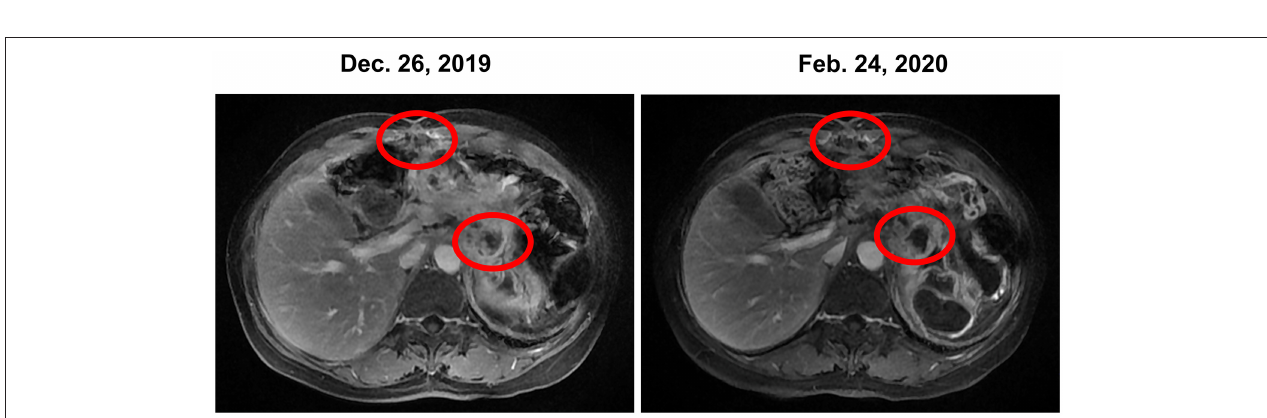
FIGURE 3 | Stable disease was observed during the treatment of trametinib combined with hydroxychloroquine based on MRI. MRI, magnetic resonance images.